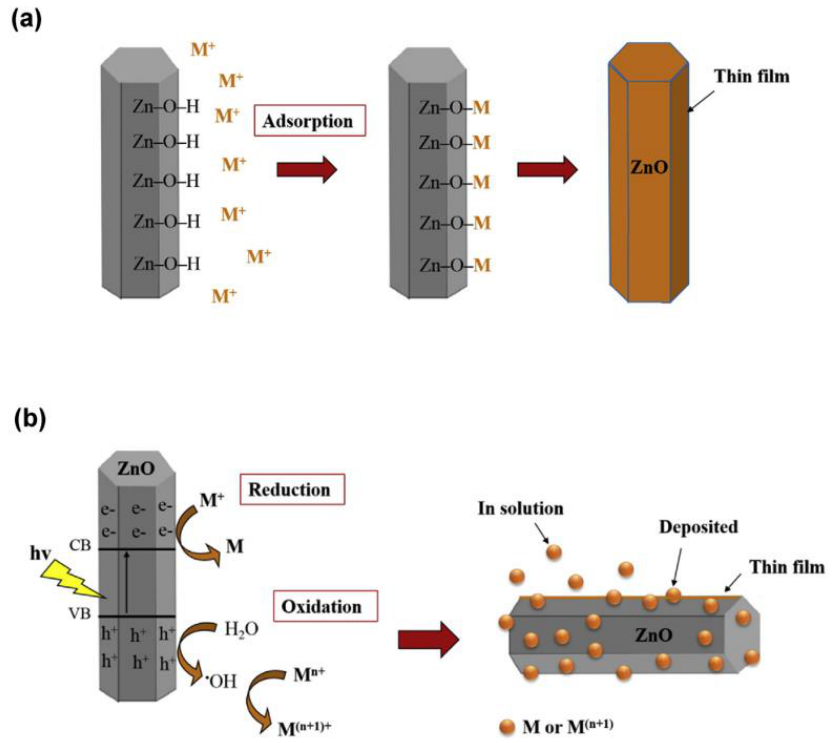
Figure 3. Removing heavy metal ions via ( a ) adsorption and ( b ) reduction / oxidation process using ZnO particles.